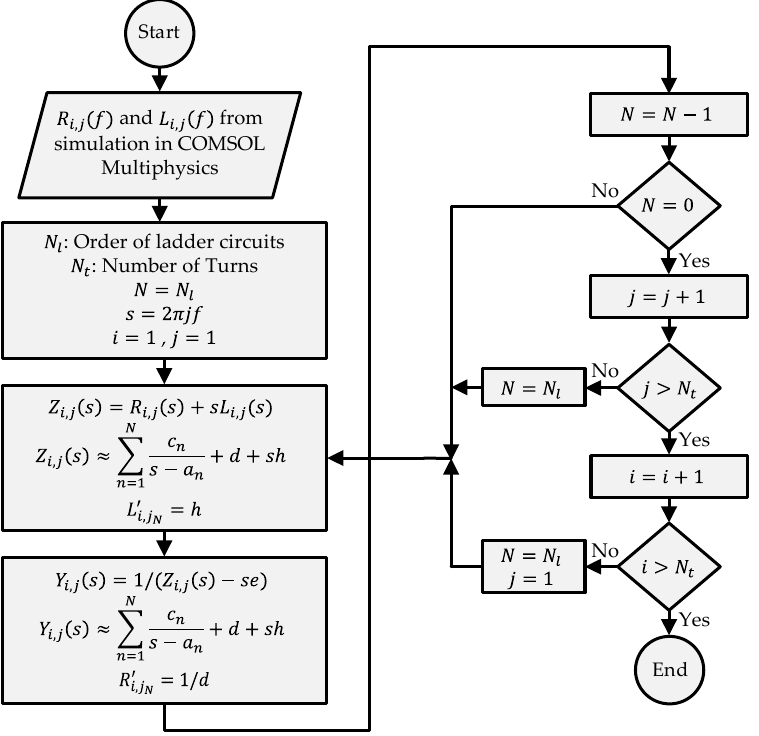
Figure 13. The flowchart to calculate elements in ladder circuits using vector fitting.